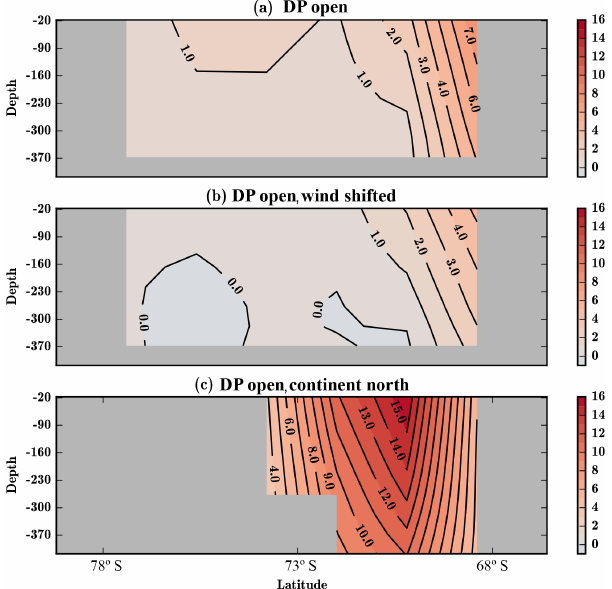
Figure 2. Meridional section of zonal velocity u (cms − 1 ) inside the Tasman Gateway with the Drake Passage open for (a) the stan- dard simulation, (b) the Southern Hemisphere westerlies shifted 6 ◦ northward, and (c) Australia and the Antarctic margin in a more northward position. All locations are well south of the latitudes of zero wind stress curl.